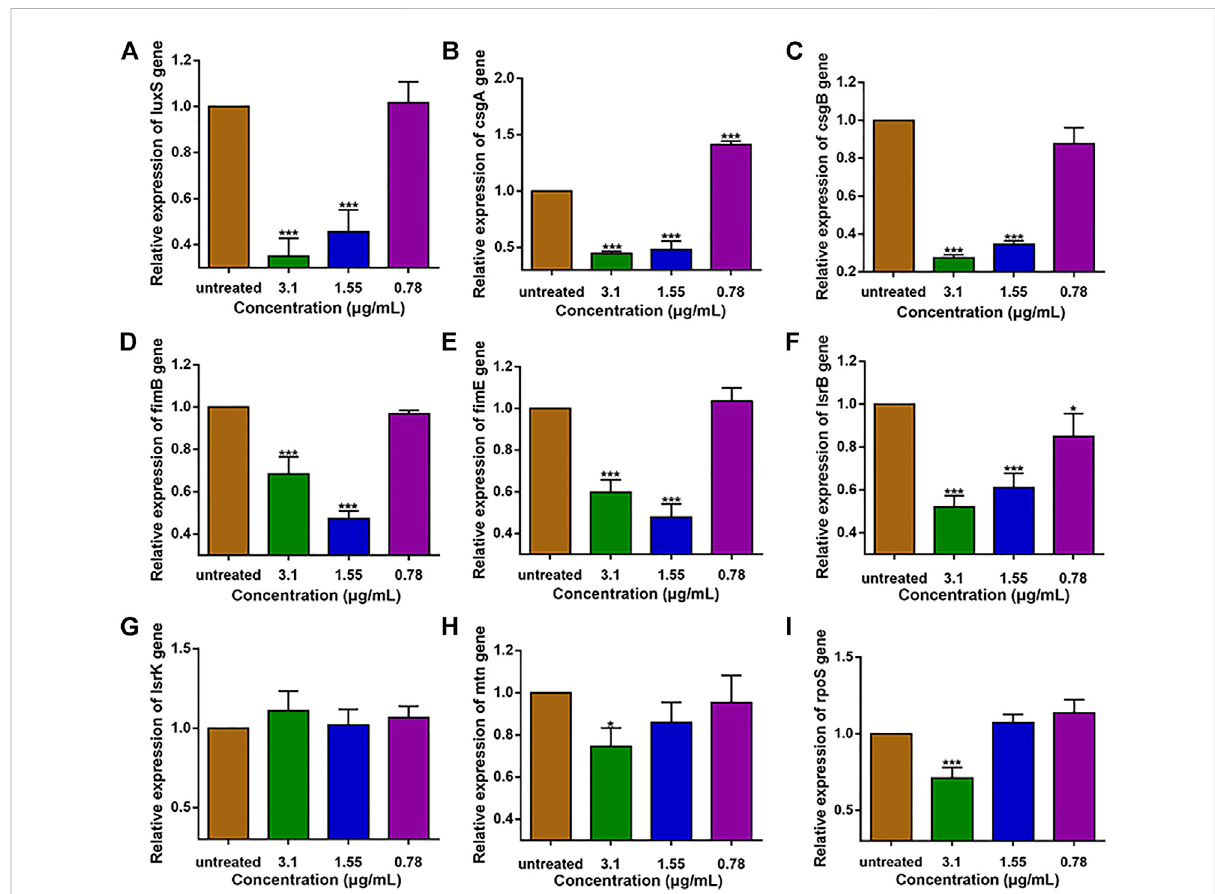
FIGURE 1 ExpressionofQS-relatedandvirulencegenesin E.coli O101after18 hinhibitionbynon-inhibitory1,8-cineoleconcentrations. (A – I) : luxS,csgA, csgB, fi mB, fi mE,lsrB,lsrK,mtn,rpoS. Theresultsrepresentmeans±standarddeviationsforthreeindependentexperiments.* p < 0.05,** p < 0.01and *** p < 0.001 versus the control